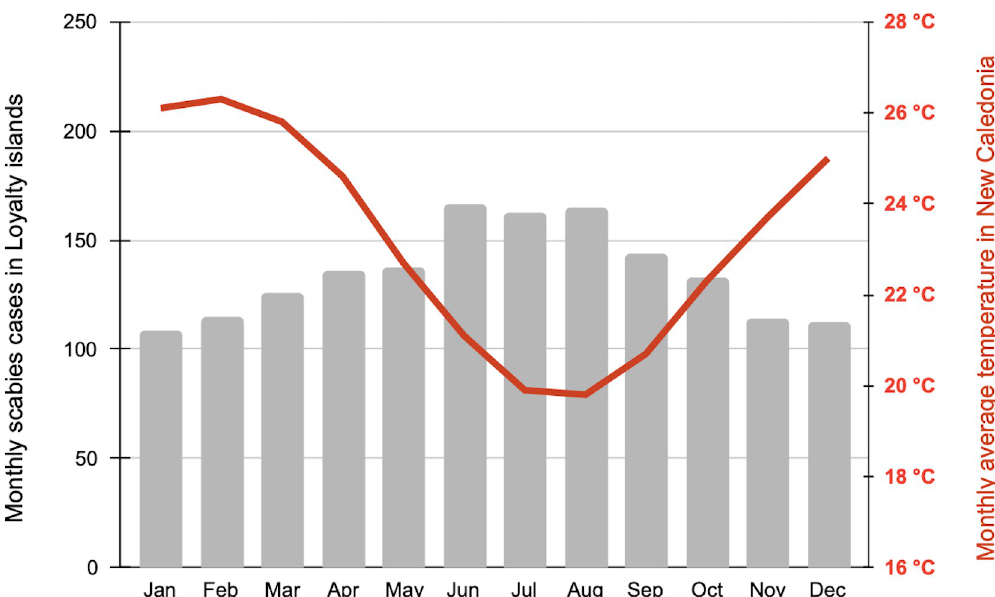
Fig 3. Average monthly number of scabies cases in Loyalty Islands Province from 2004 to 2018 and average monthly temperatures (˚C) in New Caledonia from 1981 to 2010. The histogram represents the average monthly number of scabies cases in Loyalty Islands Province (left axis); the curve represents average monthly temperatures (˚C) in New Caledonia (right axis).